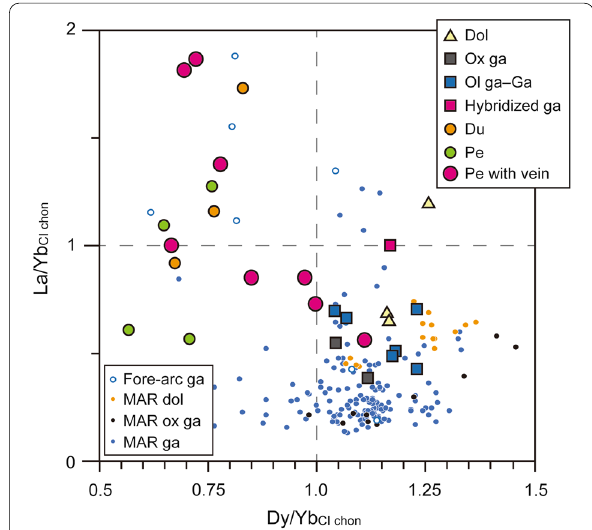
Fig. 8 Relationship between CI chondrite‑normalized ratios of La/Yb and Dy/Yb. Compositional data from fore‑arc region are after Meffre et al. (2012), Falloon et al. (2014) and Johnson et al. (2014). Those from slow‑spreading MAR are after Godard et al. (2009). CI chondrite values are after Sun and McDonough (1989). Abbreviations: CI chon CI = chondrite, Dol dolerite, Ox ga oxide gabbro, Ga gabbro, Ol = = = ga olivine gabbro, Du dunite, and Pe peridotite = = =